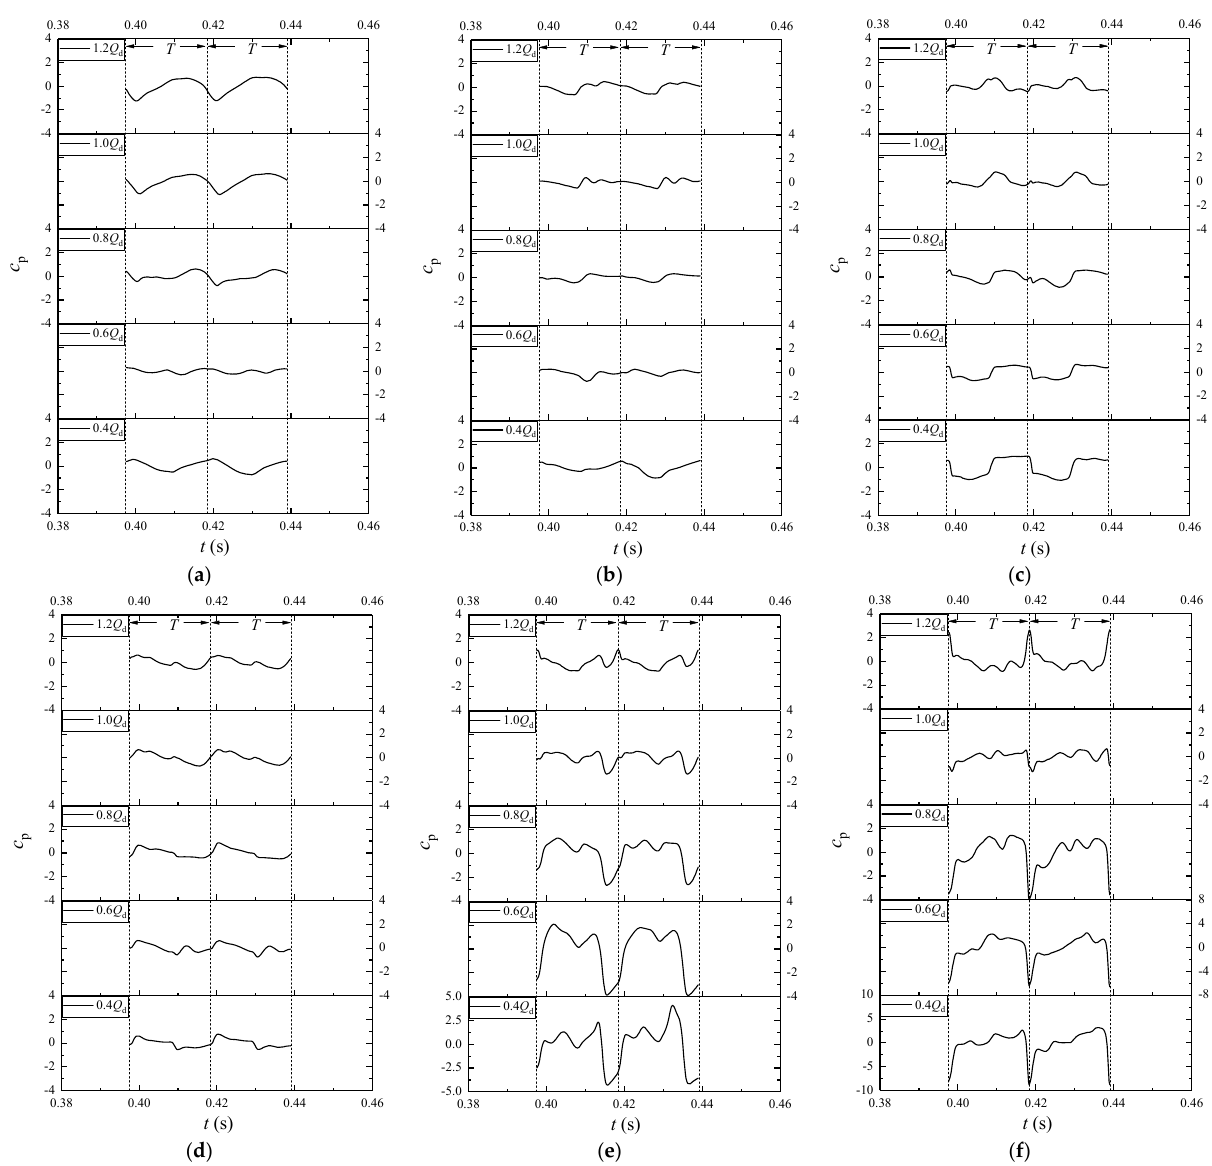
Figure 13. Pressure pulsations of impeller at different flow rates: ( a ) X1; ( b ) X2; ( c ) X3; ( d ) Y1; ( e ) Y2; ( f ) Y3. In order to reveal the spectrum characteristics of impeller at different flow rates, the typical point X3 and Y3 were selected for further spectral analysis. The spectra of pressure pulsation at X3 and Y3 are presented in Figure 14. For all the cases, the main excitation frequencies for the pressure pulsation at X3 and Y3 are impeller rotational frequency and blade passing frequency (BPF).